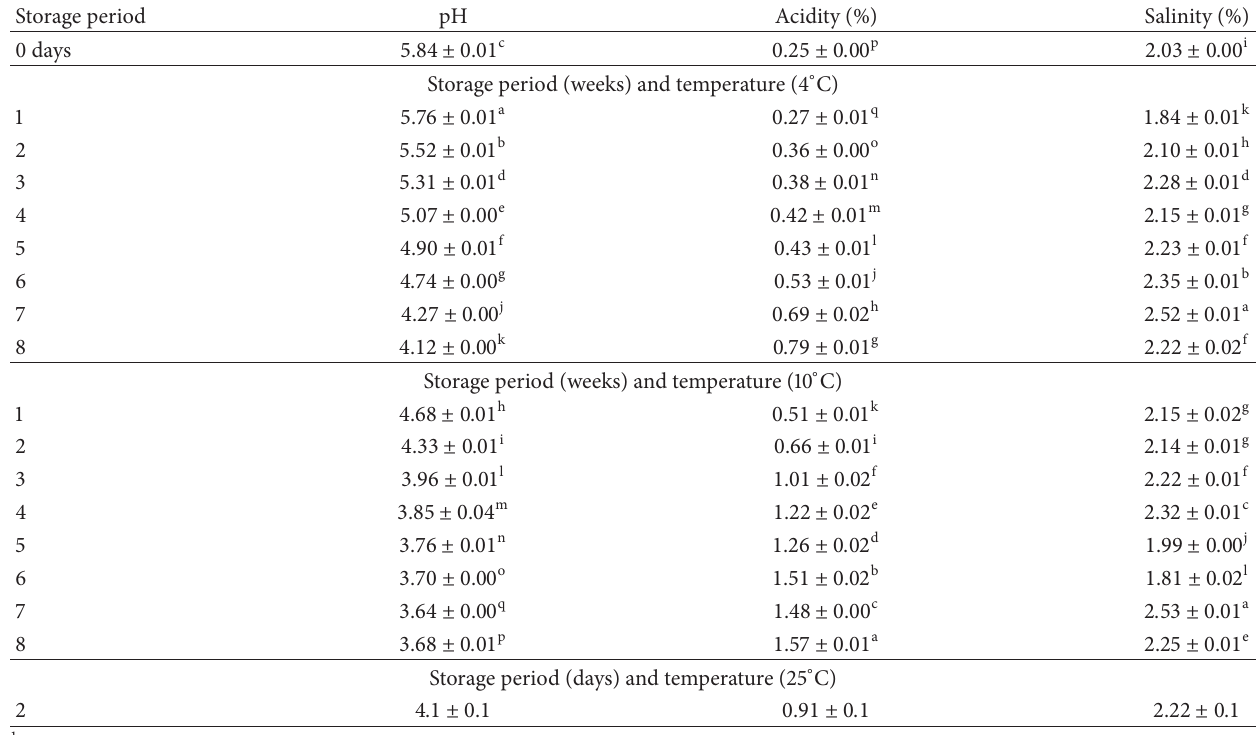
Table 3: pH, acidity, and salinity of kimchi samples stored at 4 and 10 ∘ C 1,2 . Storage